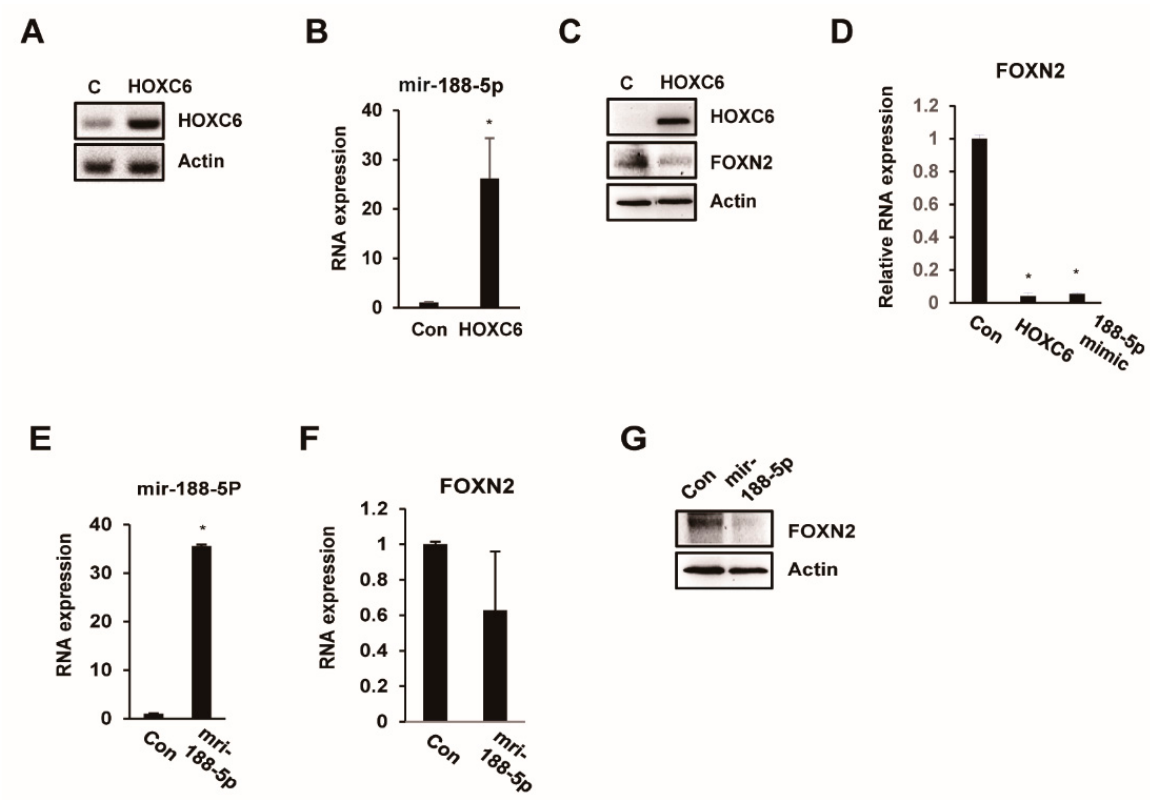
Figure 3. HOXC6/miR-188-5p modulates the expression of FOXN2. FaDu cells were transfected with pcDNA3-HOXC6 or pcDNA3 vector for 48 h, and total RNA and protein were isolated. ( A , B ) HOXC6 or miR-188-5p expression in FaDu/HOXC6 cells was analyzed by Western blotting or quantitative RT-PCR. ( C , D ) Expression of FOXN2 in HOXC6- or miR-188-5p mimic-expressing FaDu cells. Actin was used as the internal control. The qRT-PCR data are presented as the mean ± SD from three independent experiments. * p < 0.05. ( E , F ) Effects of miR-188-5p on FOXN2 expression. FaDu cells were transfected with pSuper basic vector or pSuper/miR-188-5p for 48 h. miR-188-5p and FOXN2 mRNA expression levels were quantified by qRT-PCR analysis. ( G ) Total proteins were subjected to Western blotting analysis using FOXN2 antibodies. GAPDH was used as a loading control for RT-PCR. The relative level of expression of FOXN2 mRNA normalized to GAPDH was examined by qRT-PCR. mir-188-5p expression were determined by qRT-PCR, using U6 snRNA as an internal control. * p < 0.05 vs. the